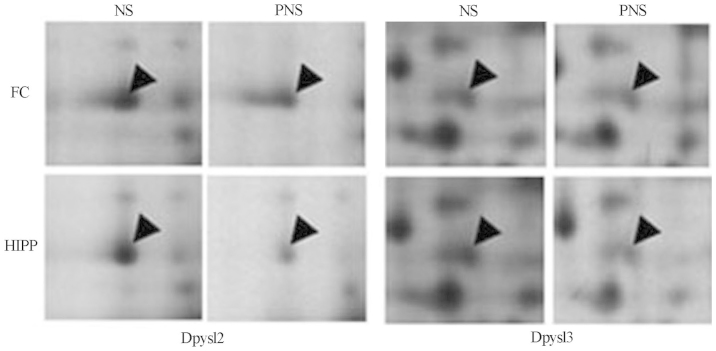
Two-dimensional gel electrophoresis patterns of protein expression in rat brains for two selected proteins. FC, prefrontal cortex; Hipp, hippocampus; NS, non-prenatal stressed offspring; PNS, prenatal stressed offspring. Arrowheads are protein spots, showing different changes among the groups.